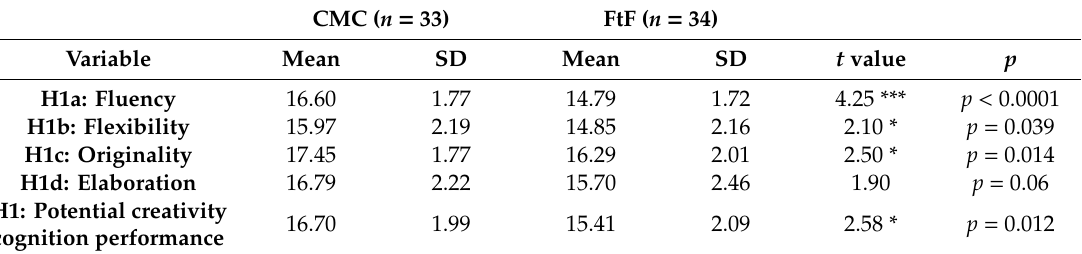
Table 9. Torrance potential creativity cognitive performance in an original-score